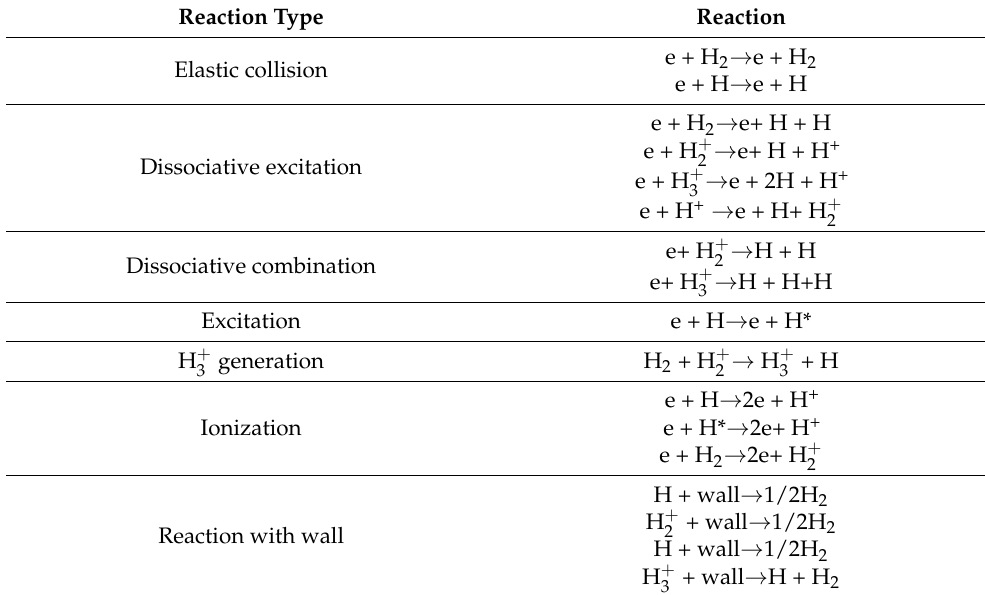
Table 1. Main reactions considered in the simulation. Reaction Type Elastic